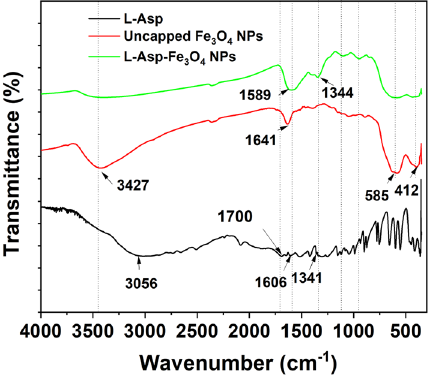
Fig. 3 The FTIR spectra of L-Aspartic acid, uncapped Fe L-Asp capped Fe 3 O 4